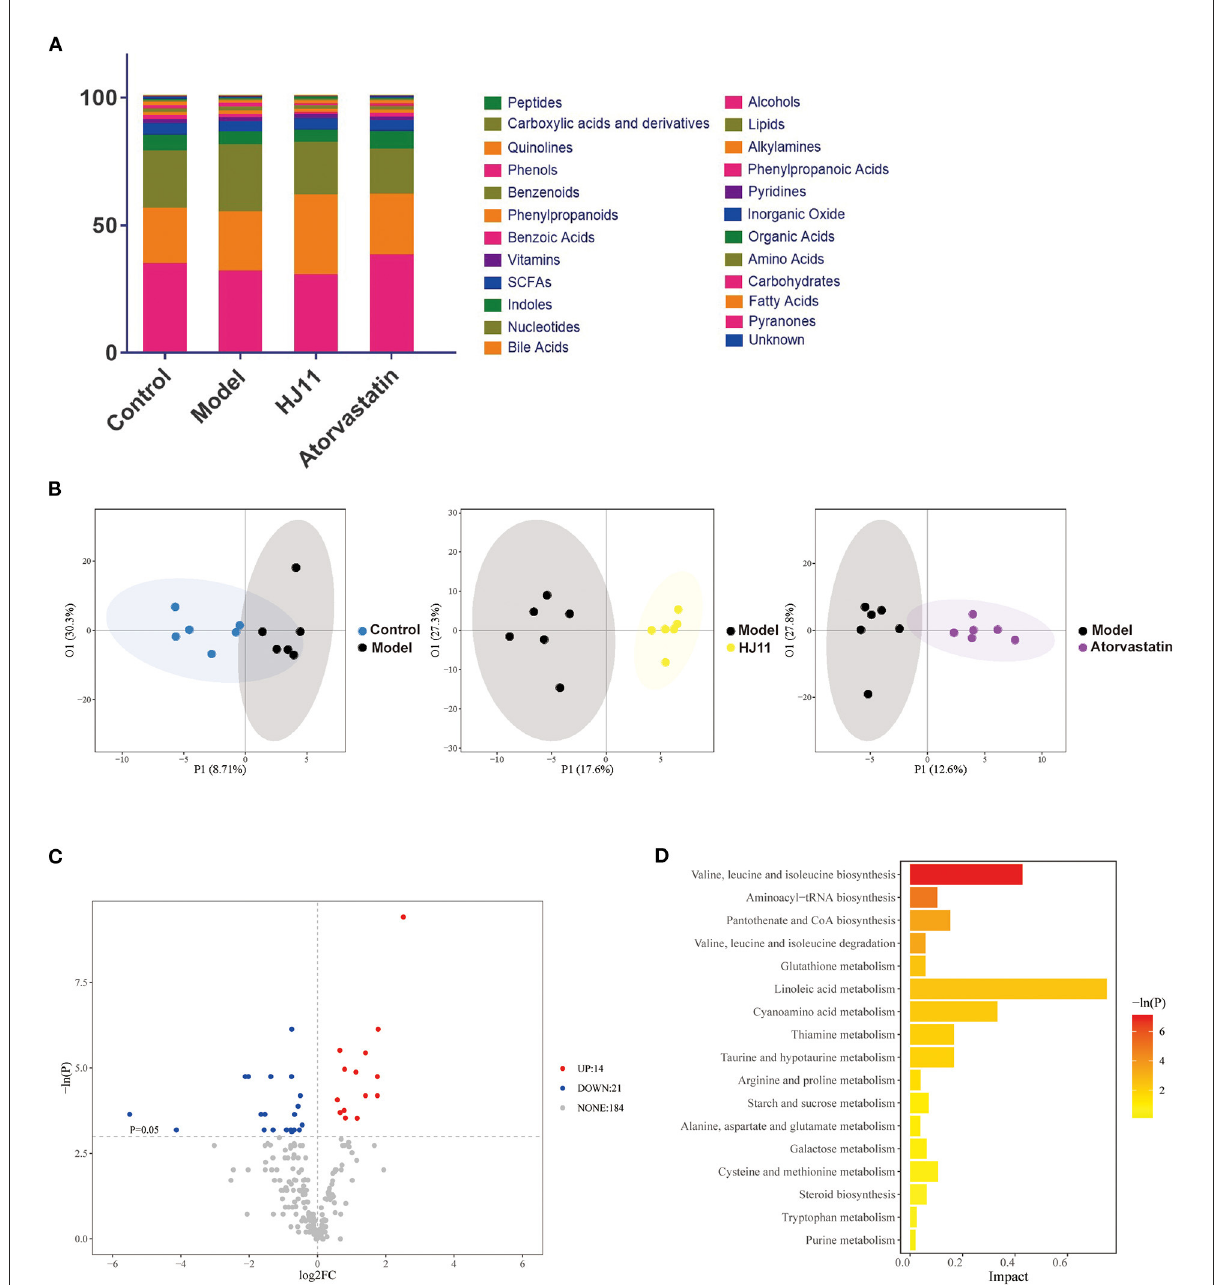
FIGURE7 Effects of HJ11 on metabolites in ACS model rats. (A) Distribution of metabolites in different groups. (B) Orthogonal PLS-DA of metabolomics results in different groups. (C) Volcano plot of metabolites in he model and HJ11 groups (screening conditions: log2FC ≥ 0 and P < 0.05). (D) Pathway enrichment based on altered